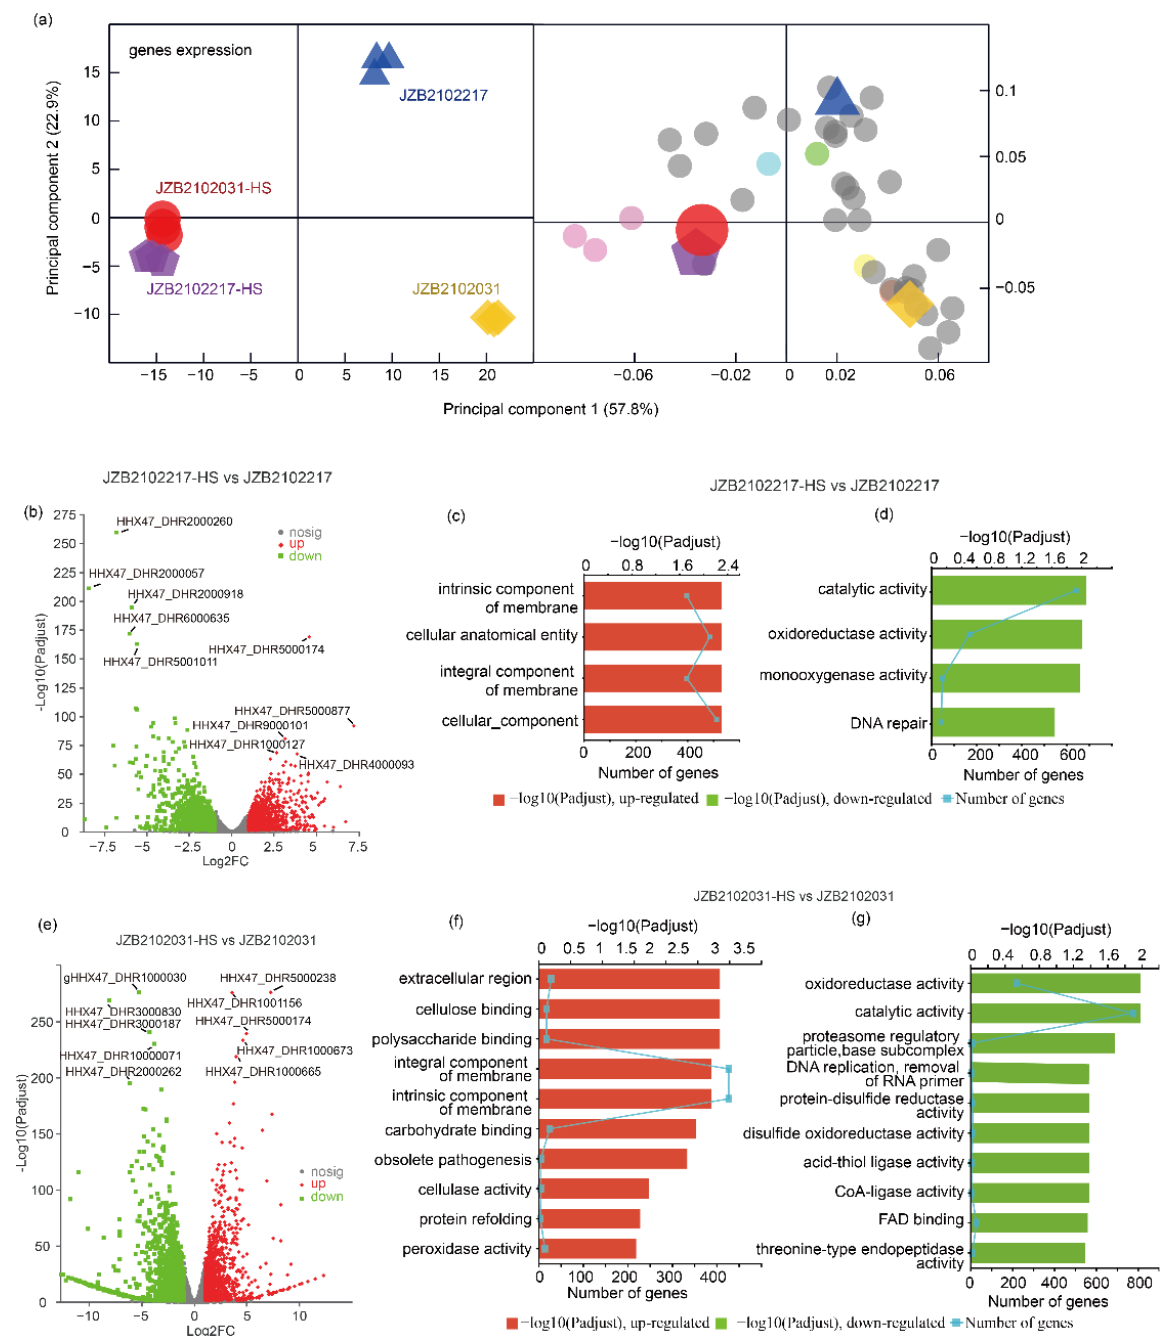
Figure 3. Gene expression analysis of H- and L-type L. edodes strains JZB2102217 and JZB2102031 in response to heat stress. ( a ) OPLS-DA analysis of transcriptome data of all samples (R2Xcum = 0.891, R2Ycum = 0.994, Q2cum = 0.931, CV-ANOVA, p = 9.835 × 10 − 7 ). OPLSDA loading showing the genes whose VIP > 4; color indicates the KEGG pathways (light bule—endocytosis; light orange—methane metabolism; light pink—protein processing in endoplasmic reticulum; light yellow—glycerophospholipid metabolism; grey—unannotated). ( b , e ) The volcano plot of expressed genes in H- and L-type strains upon exposure to heat, respectively. ( c , d ) The top 10 enriched GO terms of up- and down-regulated genes in H-type strains upon exposure to heat, respectively. ( f , g ) The top 10 enriched GO terms of up- and down-regulated genes in H-type strains upon exposure to heat, respectively.